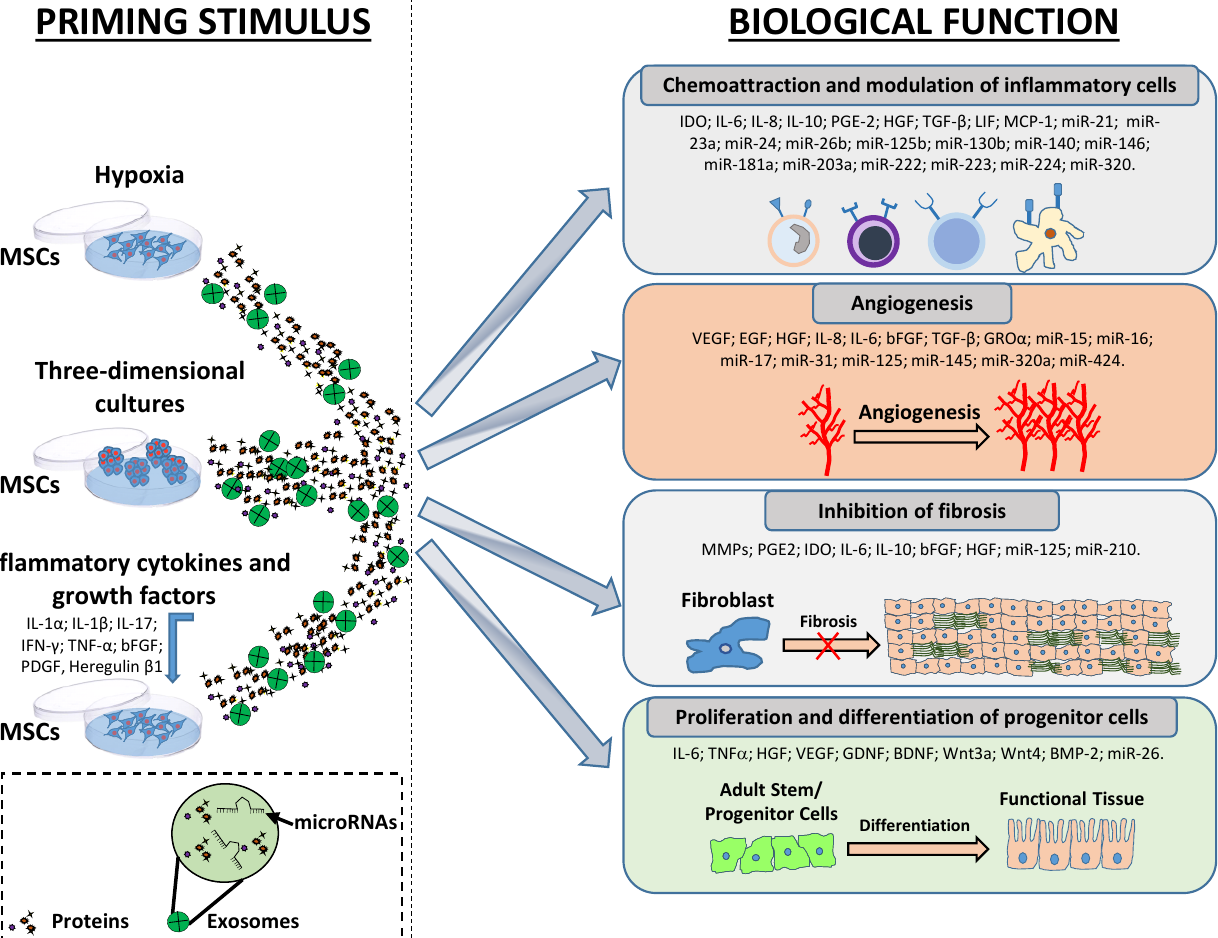
Figure 2. Schematic representation of the molecular effects after priming of MSCs. MSCs can be primed through different stimuli, including hypoxia, three-dimensional cultures, growth factors and cytokines, to enhance their therapeutic potential. In these cases, MSCs produce inducible regulatory factors such as growth factors, cytokines, chemokines and exosomes (which contain both proteins and microRNAs). Primed MSCs promote tissue regeneration/repair regulating different processes including inflammation and angiogenesis, the production of the extracellular matrix (ECM) and the regeneration of functional cells by differentiation of their progenitor cells.